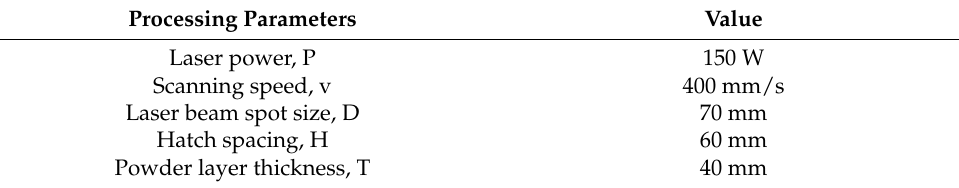
Table 2. SLM processing parameters.